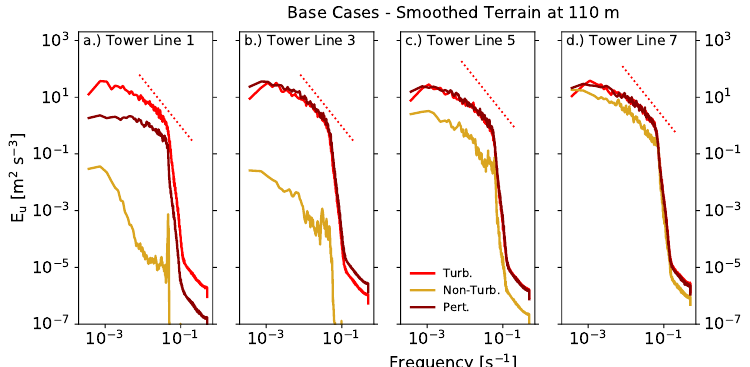
Figure 13. Tower line averaged spectra of the u -component wind speed for the smoothed terrain Base cases at tower lines 1, 3, 5, and 7 in panels ( a – d ), respectively. The red dotted line indicates the − 5/3-slope.